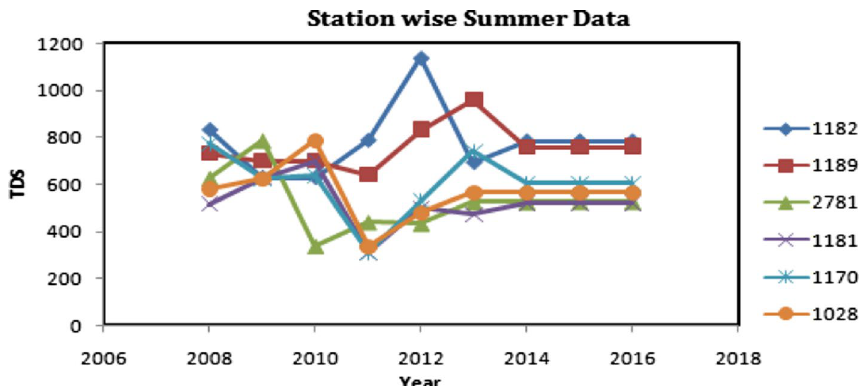
Fig. 6 Year-wise data of TDS at each station for summer season